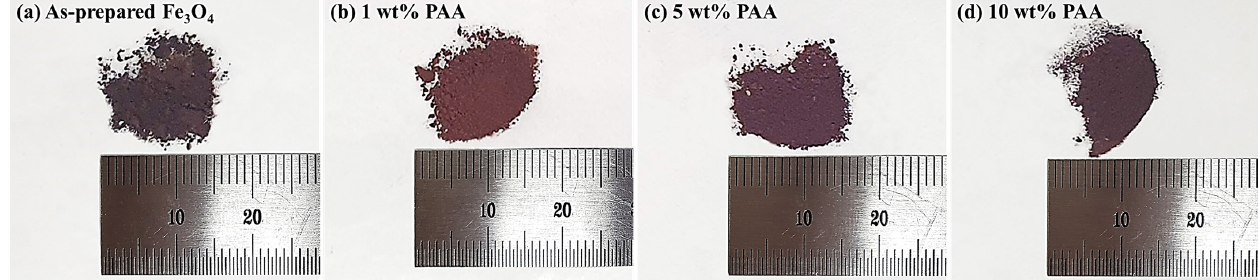
Figure 6. Images of dried as-prepared Fe 3 O 4 and Fe 3 O 4 –PAA: ( a ) as-prepared Fe 3 O 4 ; ( b ) 1 wt % PAA; ( c ) 5 wt % PAA; ( d ) 10 wt % PAA.